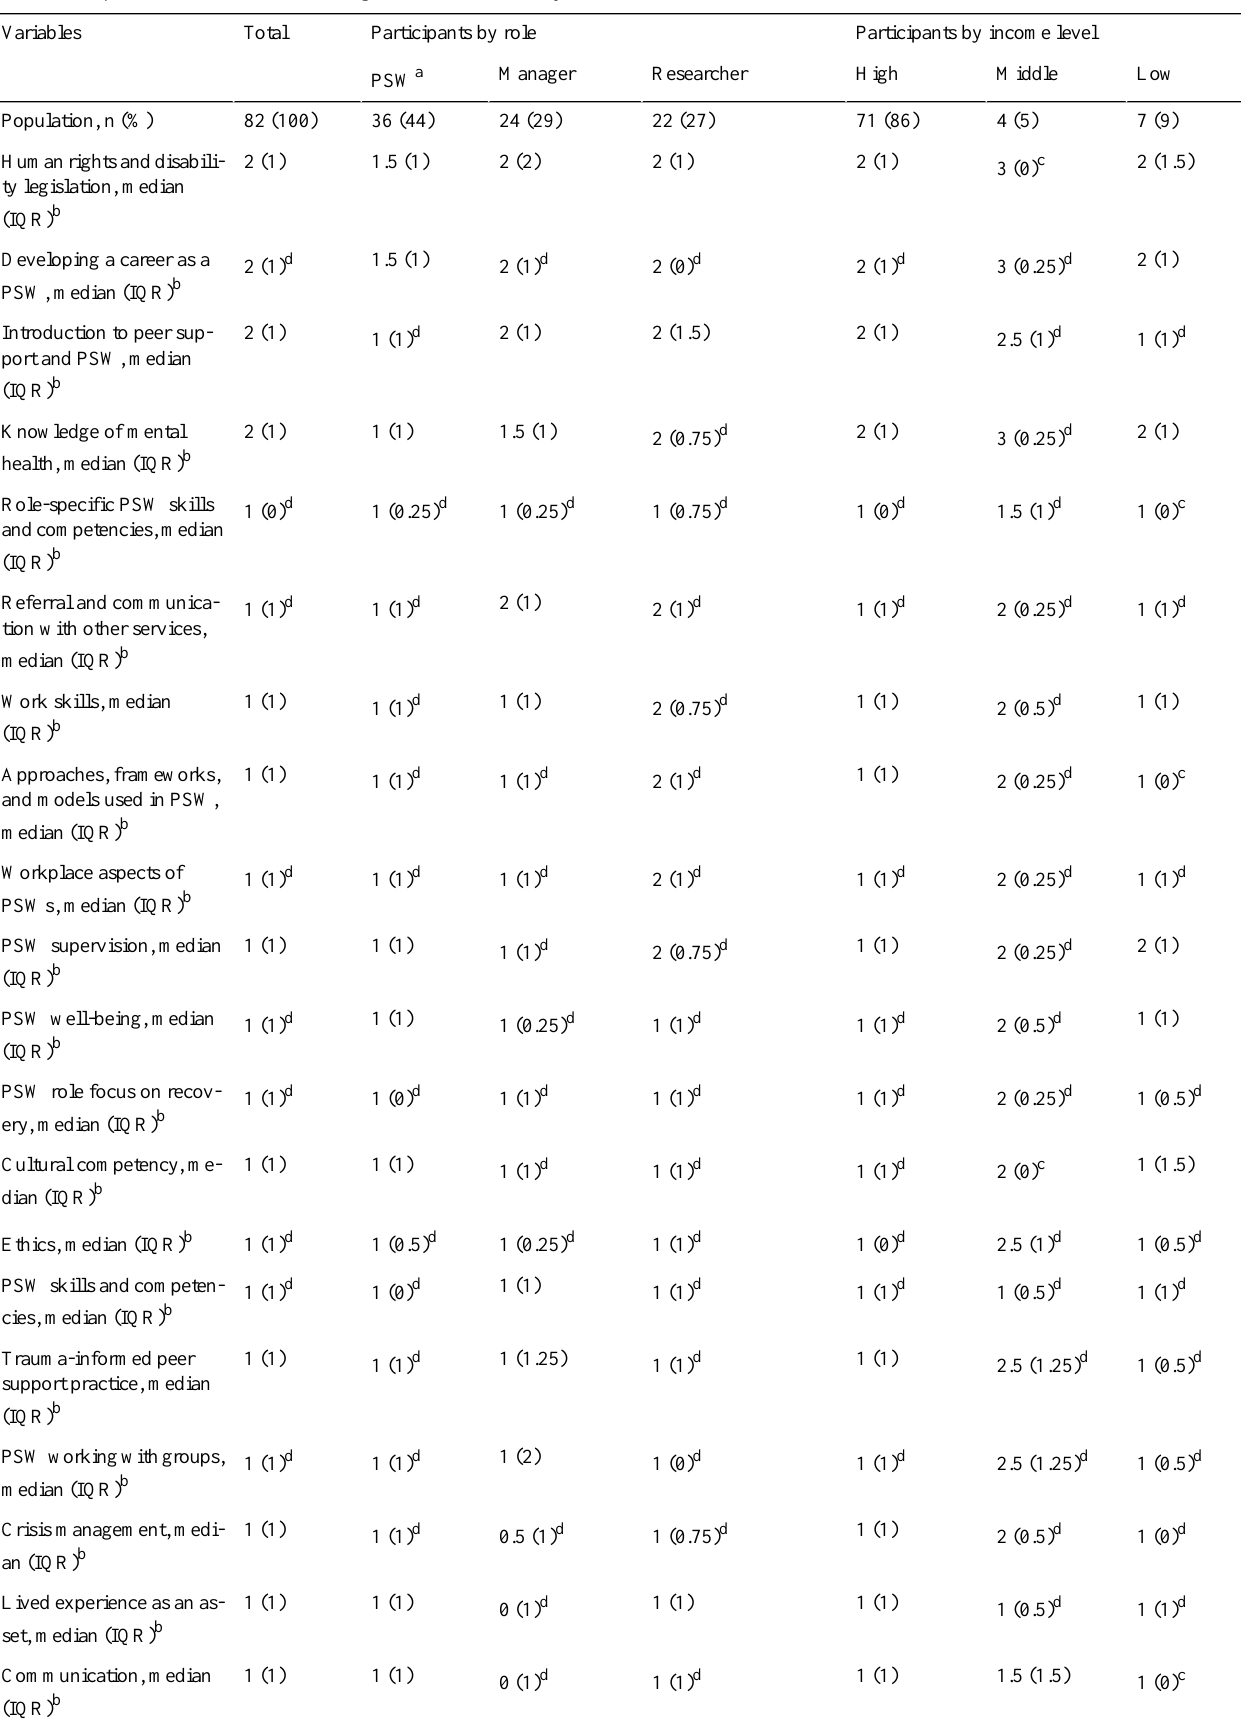
Table 3. Delphi Consultation round 3 rating of web-based delivery (n=82).